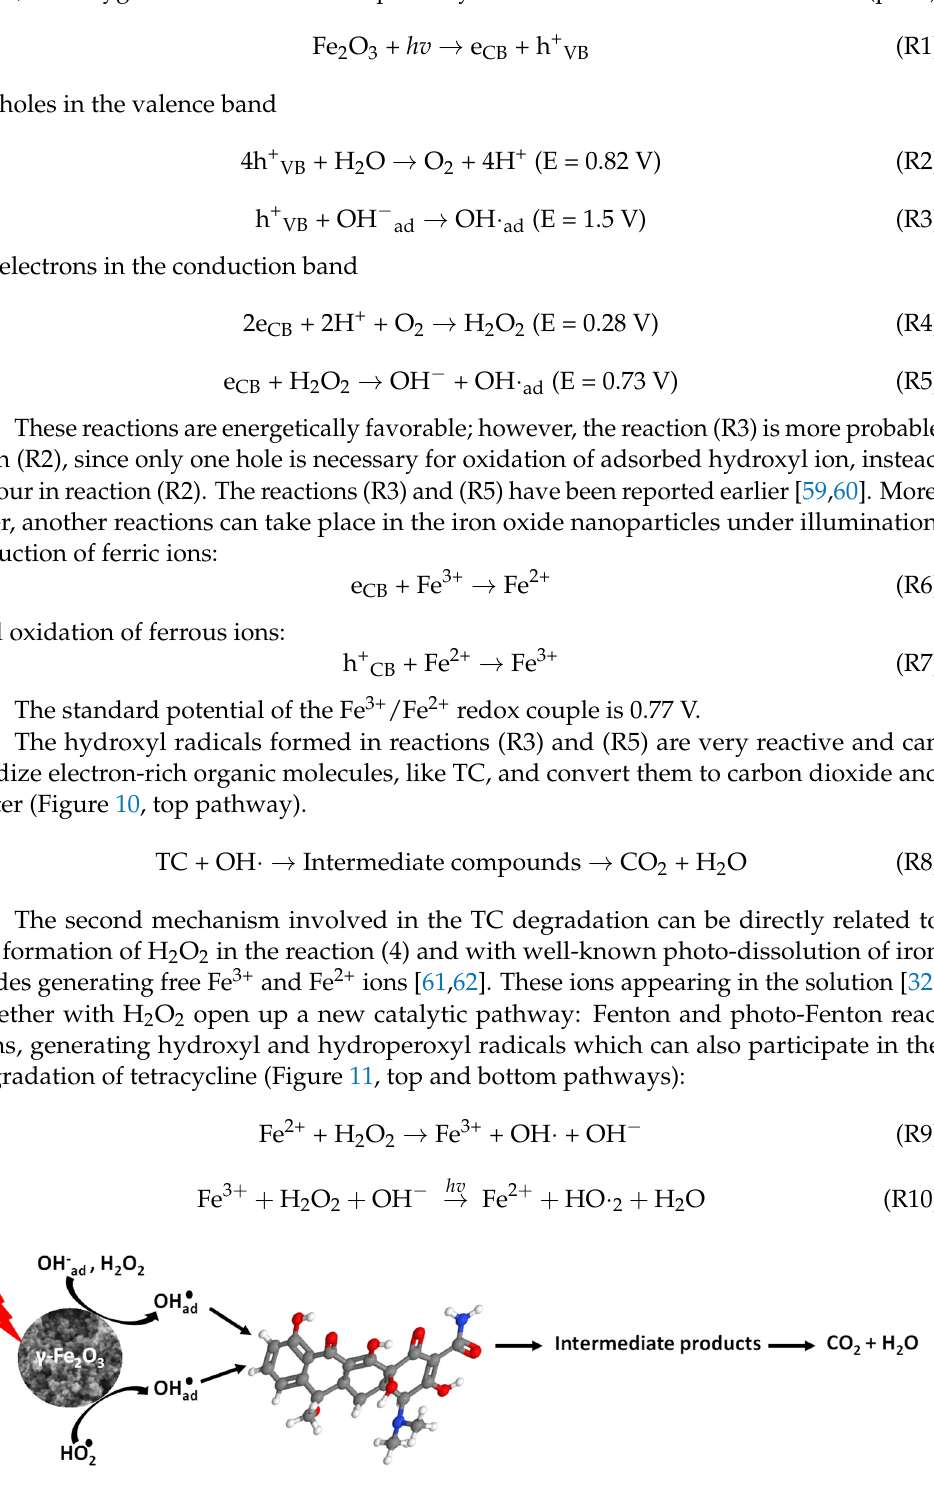
Figure 11. Photocatalytic degradation of tetracycline reaction with hydroxyl radicals.